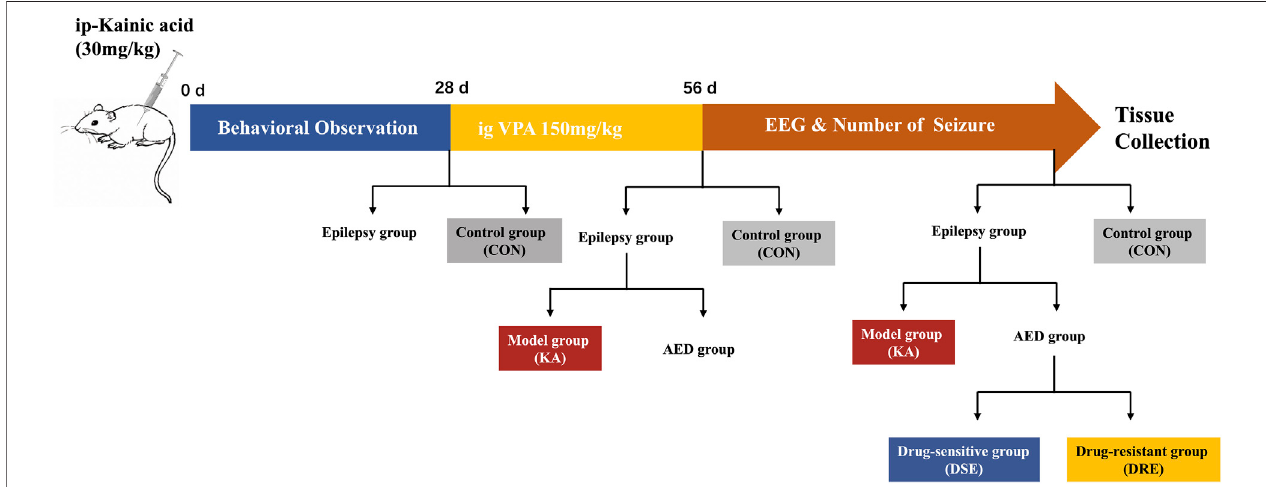
FIGURE 1 | Schematic showing the creation of a VPA-resistant epilepsy model in mice. Step 1: Sixty mice with temporal lobe epilepsy were established by intraperitoneal administration of KA. Step 2: twenty epilepsy mice were assigned into epilepsy model, and 48 epilepsy mice were treated with VPA for 4 weeks. Step 3: After administration, the mice were divided into VPA-sensitive group and VPA-resistant group according to their epileptic behavior and EEG data.